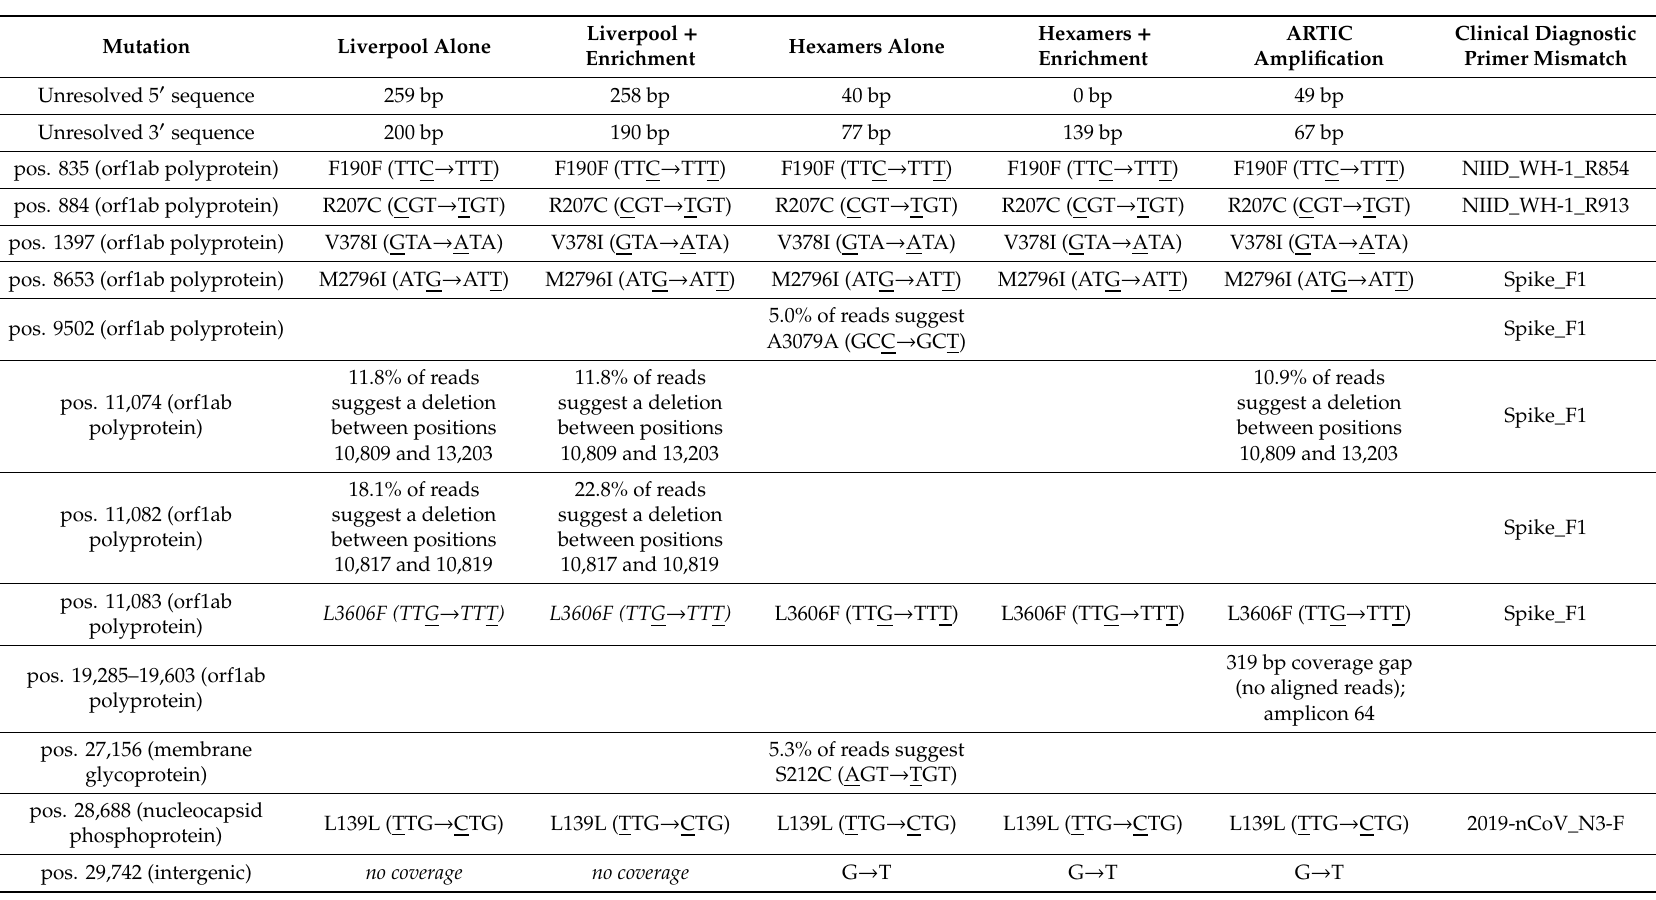
Table 2. Predicted mutations relative to the MN908947.3 SARS-CoV-2 genome for each library for the high titre Iran-derived sample identified by BreSeq analysis of sequencing reads. Mutations within codons are underlined. All mutations were predicted by 100% of sequencing reads mapping to that position unless otherwise noted. Mutations in bold existed in the final iVar-called genome sequence, while those in italics exist in the final iVar-called genome sequence but were obscured by deletion predictions in the minority reads for